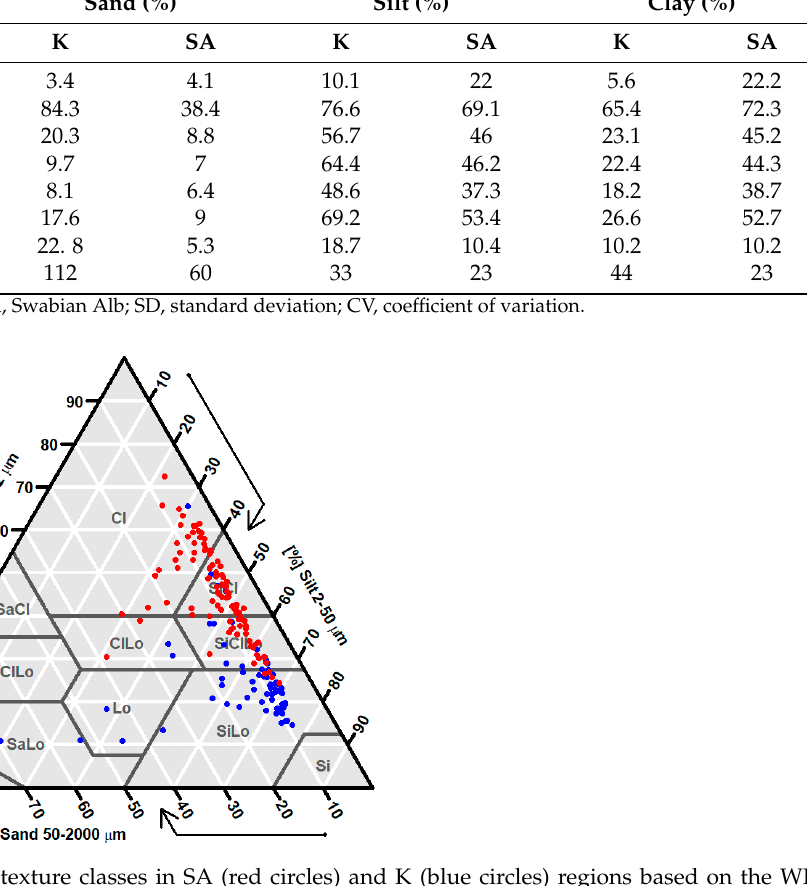
Table 2. Summary statistics of soil textural fractions in the study regions. Sand (%) Silt (%) Clay (%)